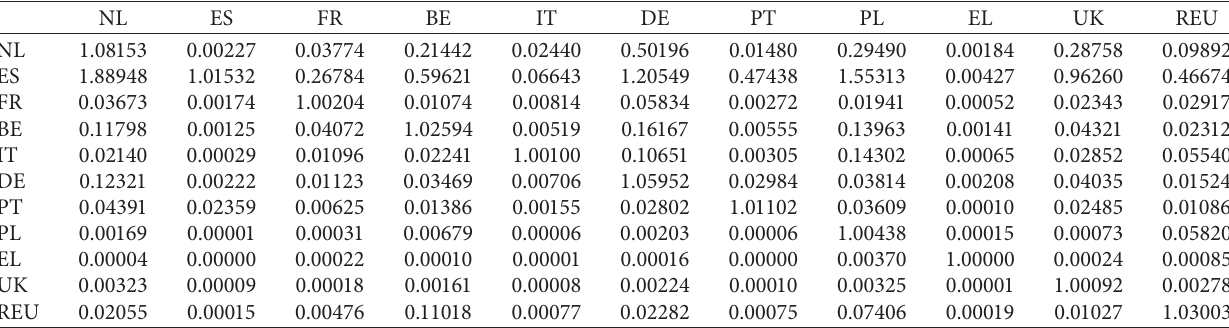
Table 7: Inverse matrix 2002.